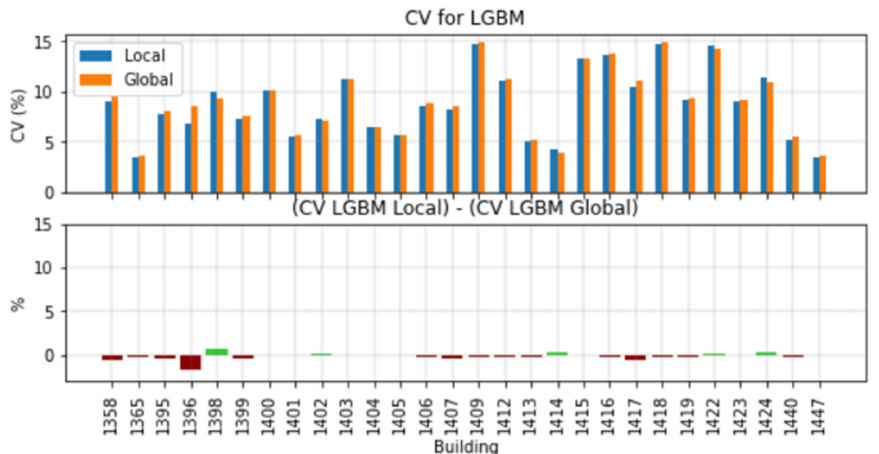
Figure 11. Comparison (in the upper figure) and difference (in the lower figure) between the CV obtained from local and global LGBM models on test